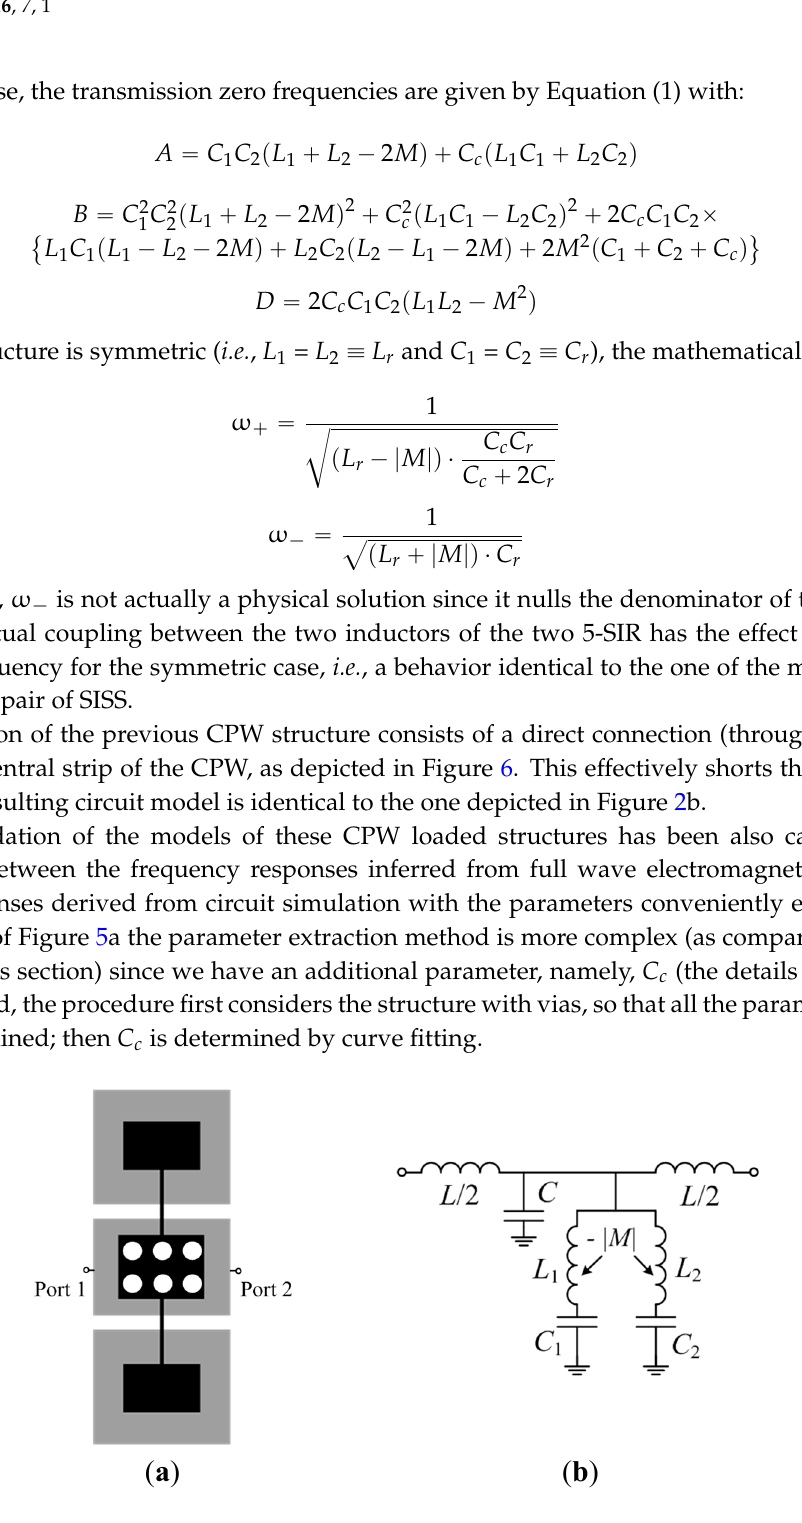
Figure 6. ( a ) CPW loaded with a 5S-SIR directly in contact to the central strip of the CPW through metallic vias, and ( b ) circuit